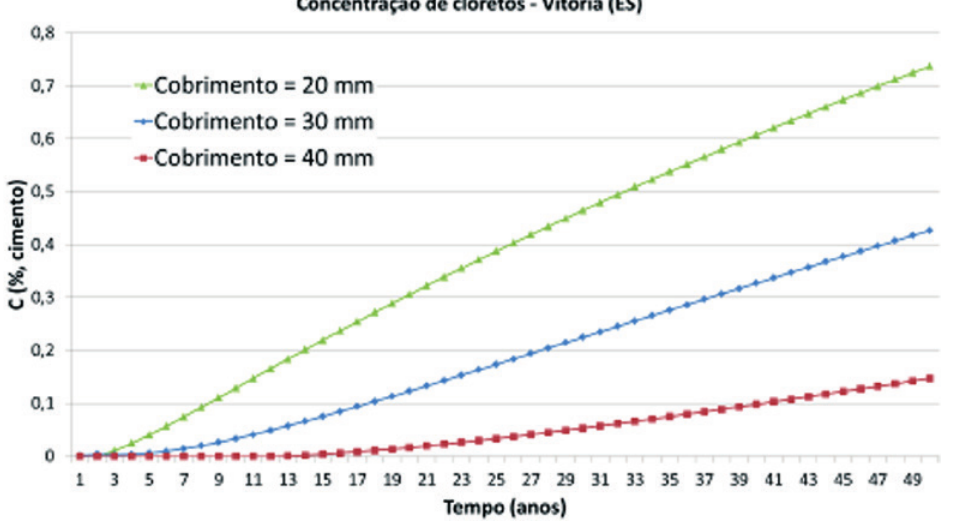
Variação da concentração de cloretos em Vitória –